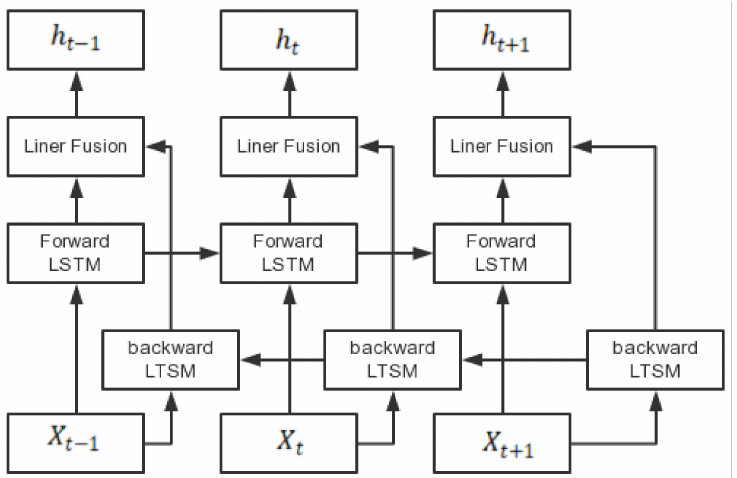
Figure 3. Bi-LSTM structure